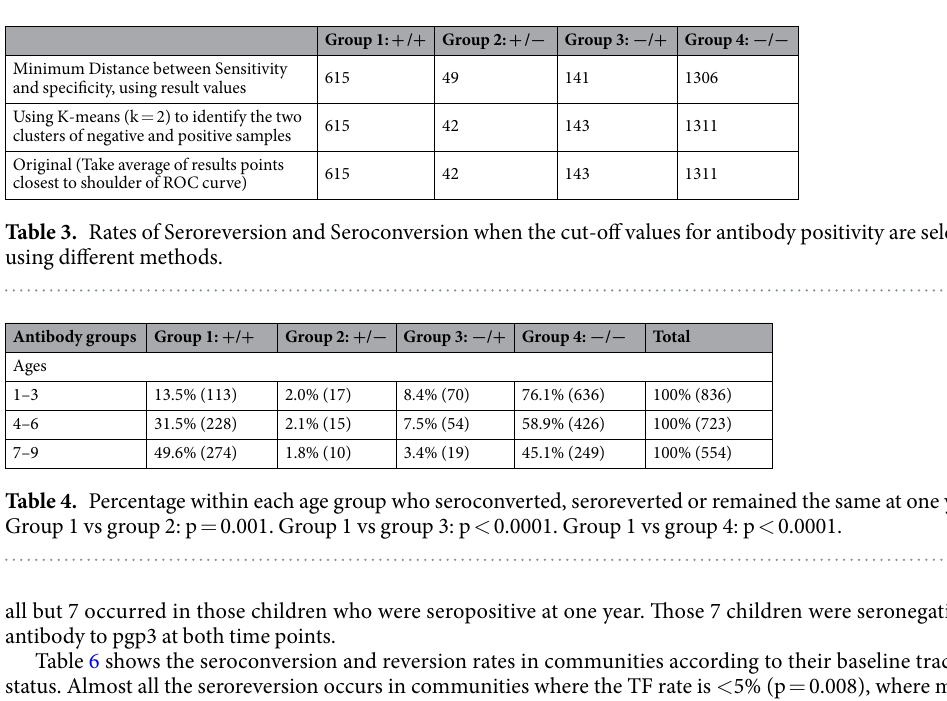
Figure 3. Log 10 MFI-BG at one year follow up for the longitudinal cohort within the four groups according to antibody status at baseline and follow up.